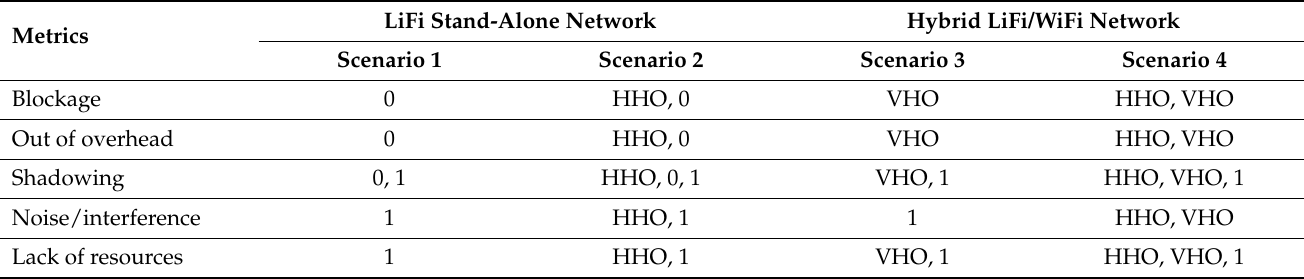
Table 7. Causes and effects of different metrics on LiFi, and LiFi/Wi-Fi hybrid networks that could trigger different types of events such as handover or